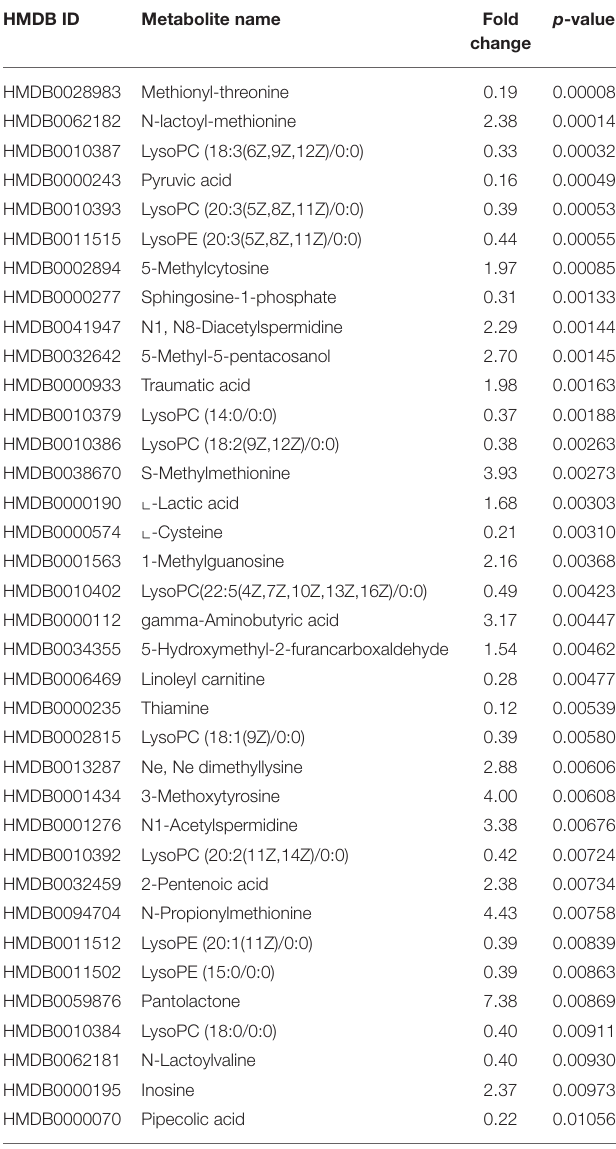
TABLE 2 | Top metabolites that differentiate patients with and without CVAEs (with fold change > 1.5 or < 0.5 and p <